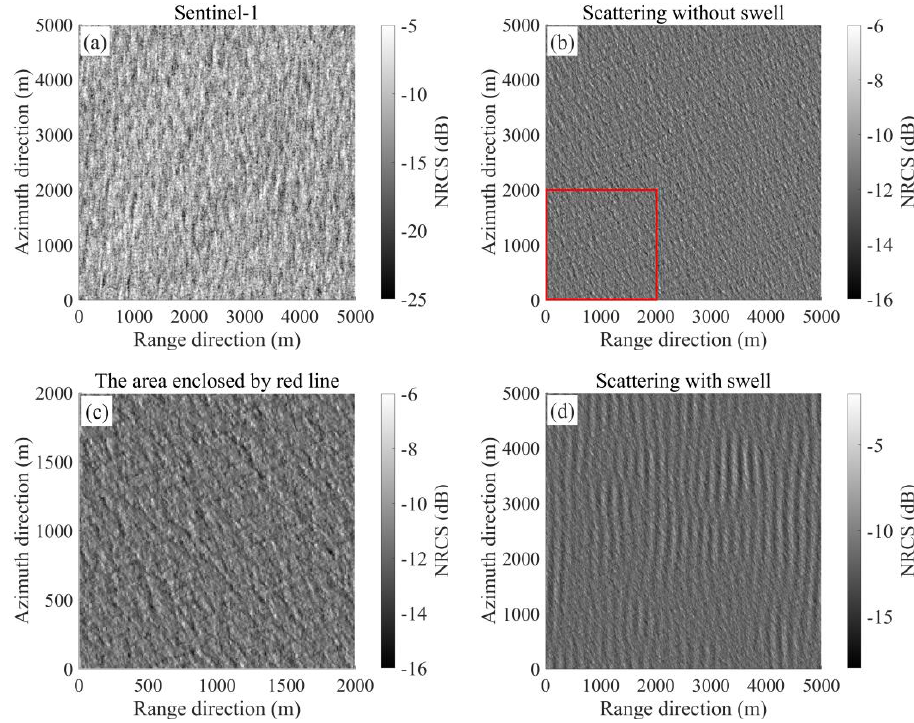
Figure 21. Similar to Figure 17 but corresponding to ID 3.